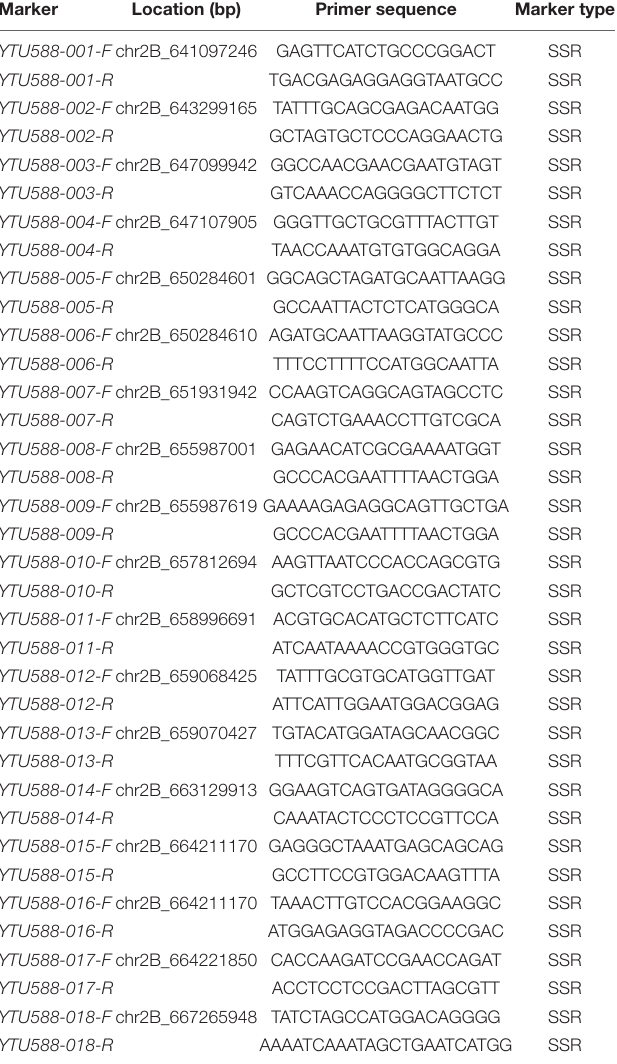
TABLE 3 | Molecular markers that were newly developed using BSR-Seq for the powdery mildew resistance gene PmYD588. Marker Location